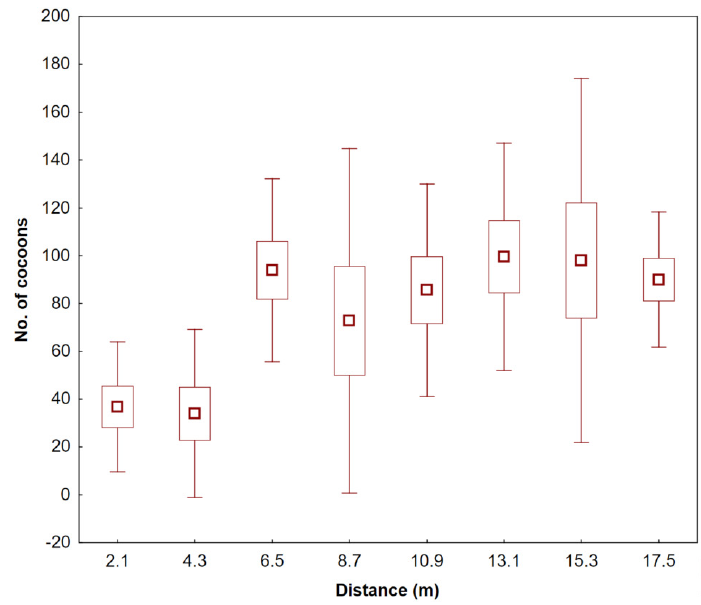
Fig 1 . Box plots despicts mean, standard error (box) and standard deviation (whiskers) of the number of E. rudis cocoons according to distance from wood ant